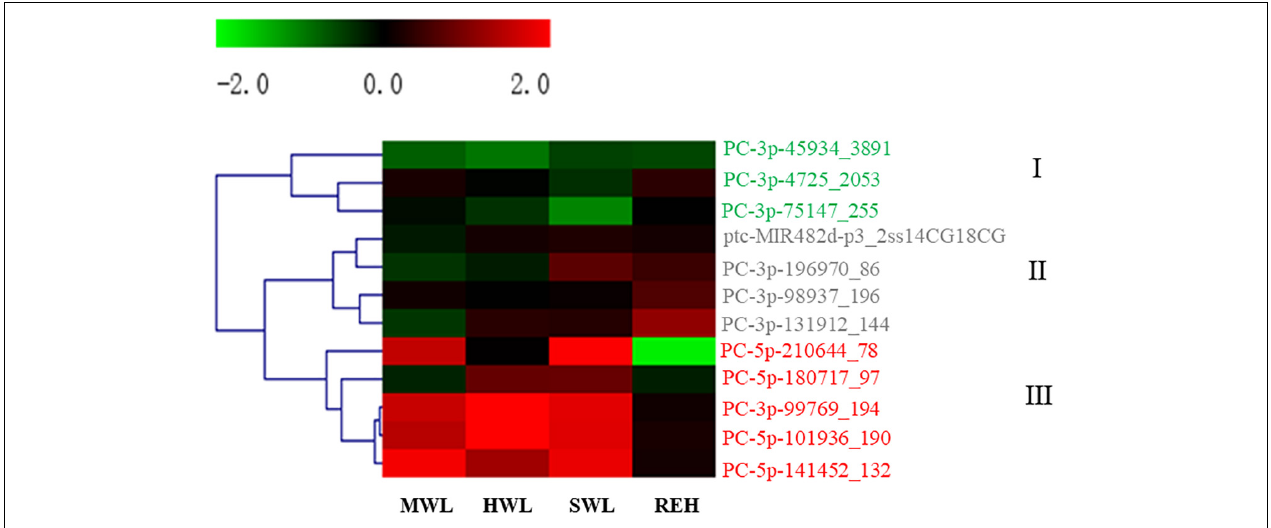
FIGURE 2 | Expressional patterns of miRNAs during desiccated stresses. CON, Normal conditions (control); MWL, 30 ± 5% water loss rate (moderate water loss); HML, 50% ± 5% (severe water loss); SWL, 80% ± 5% (Severe water loss); REH, the gametophytes from SWL were put back into seawater to rehydrate for 30 min. The expressional variation was represented by fold-change = log 2 (FPKM under stress/FPKM under control). The miRNAs in cluster I, II, and III have been depicted in green, gray and red, respectivley.